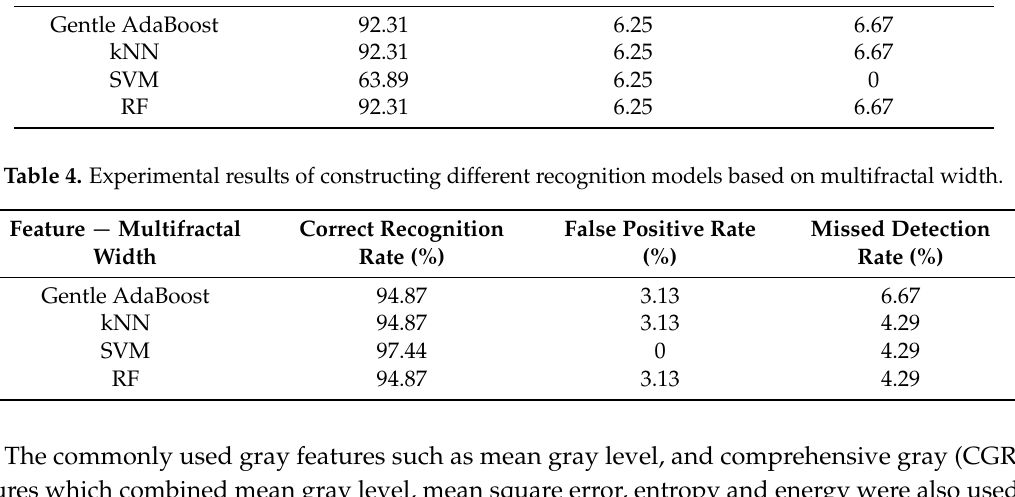
Table 3. Experimental results of constructing different recognition models based on D .